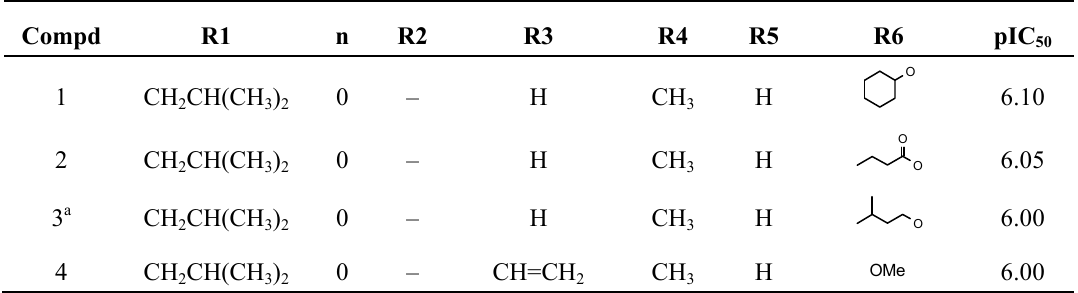
Table 3. Structures and activities of all the dibenzodioxepinone and dibenzodioxocinone derivatives used for 3D-QSAR